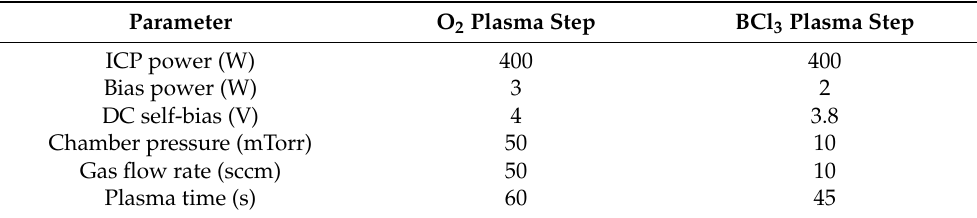
Table 1. Optimized ALE process conditions.